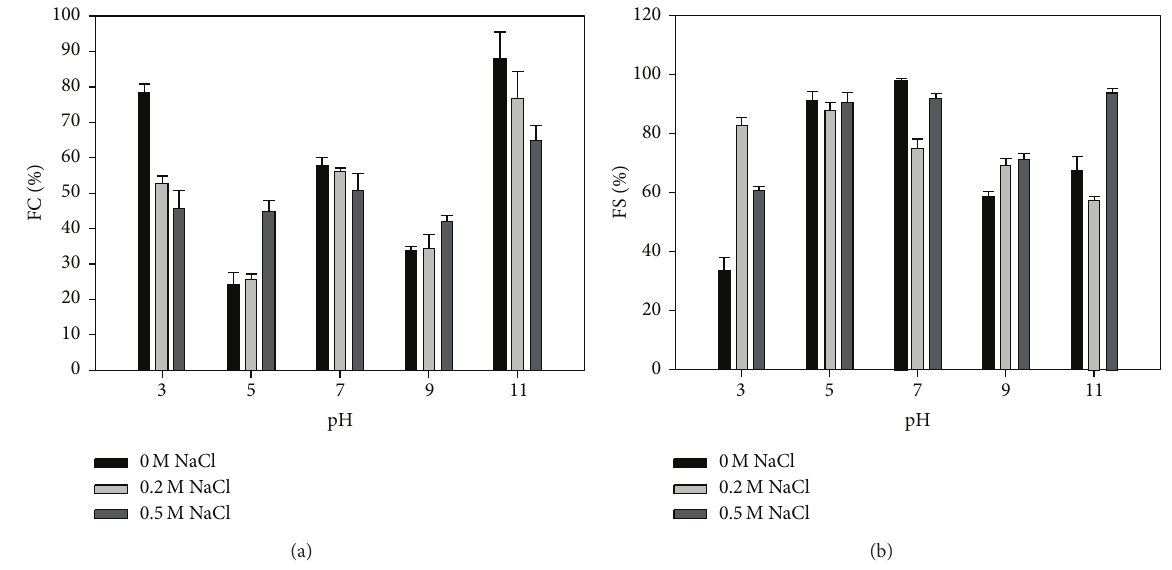
Figure 6: Effect of pH and NaCl concentration on (a) foaming capacity (FC) and (b) foam stability (FS) of SP from jumbo squid mantle. Data represent the mean ± standard deviation ( 𝑛 = 3